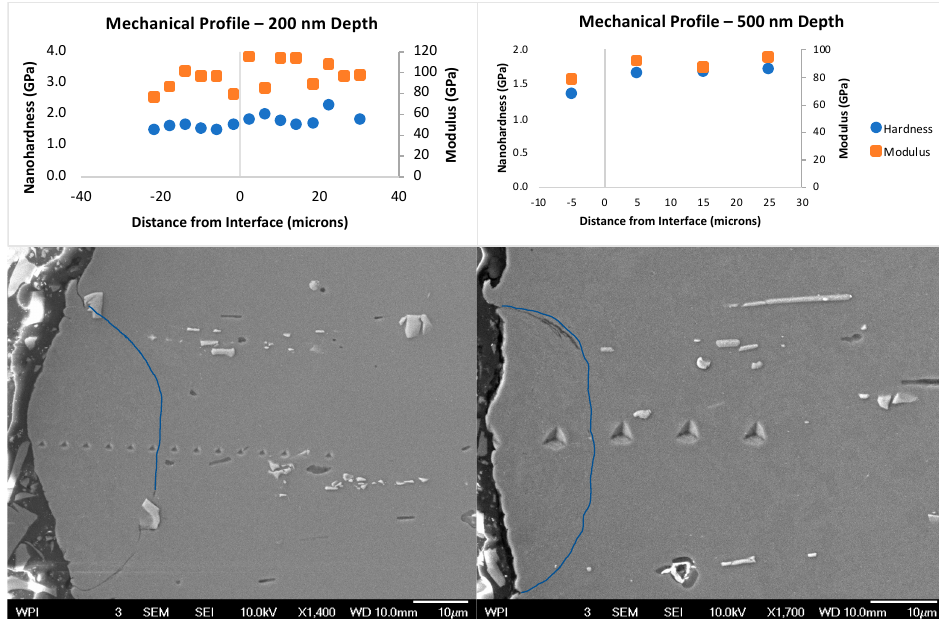
Figure 50. ( Upper Left ) hardness and modulus values for the indentation profile captured in the SEM micrograph ( Bottom Left ). Negative values are within the particle, the (0,y) point is the particle / substrate interface, and positive position values are within the substrate material. The ( Upper Right ) graph and ( Bottom Right ) micrograph follows the same reasoning associated with the ( Upper Left ) and ( Lower Left ); however, the indentation depths were 500 nm instead of 200 nm.